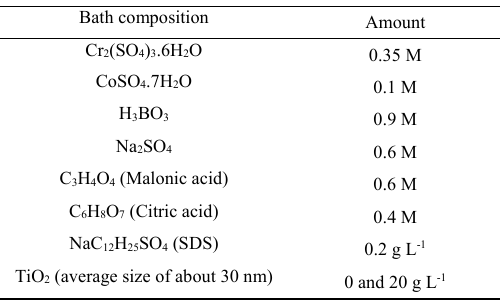
Table 1. The electrodeposition bath composition of Co-Cr and Co-Cr/TiO 2 coatings Bath composition